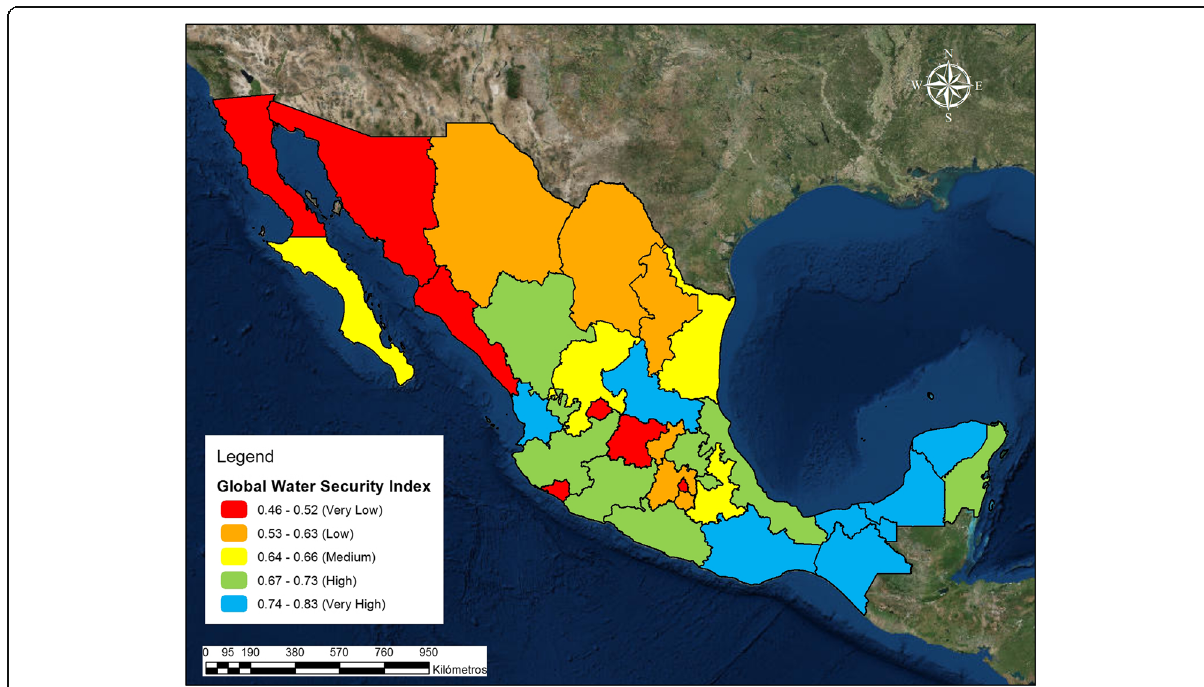
Fig. 3 Global water security index at the state